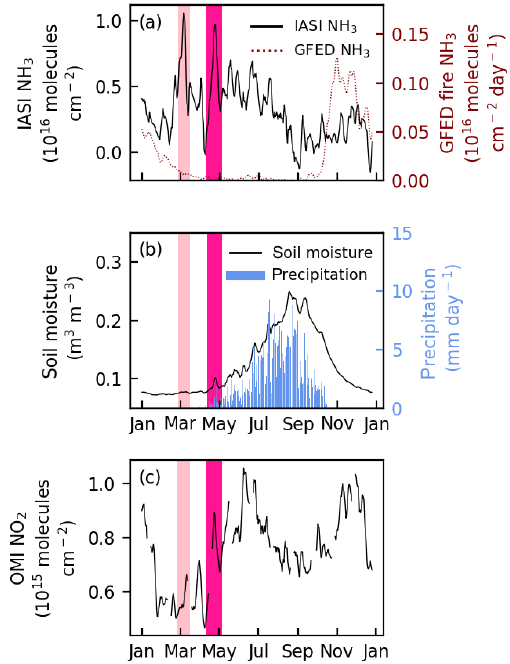
Figure 2. Early growing season NH 3 pulses temporally associated with changes in soil moisture and with NO 2 pulses over the fo- cal study region in the Sahel during 2008. (a) Daily atmospheric NH 3 concentrations from IASI and NH 3 biomass burning emissions from GFED4s. (b) ESA-CCI soil moisture and TRMM precipita- tion. (c) Tropospheric NO 2 concentrations from OMI. Putative soil emission pulses in March and April are highlighted in bright and dark pink, respectively. Mean NO 2 concentrations were calculated using values of 0.25 ◦ grid cells within the study region for which NH 3 observations were also present. GFED4s emissions were con- verted from a mass-based to molecule-based flux to allow for com- parison with the IASI retrievals; note the different scales for the left and right y axes of panel (a)